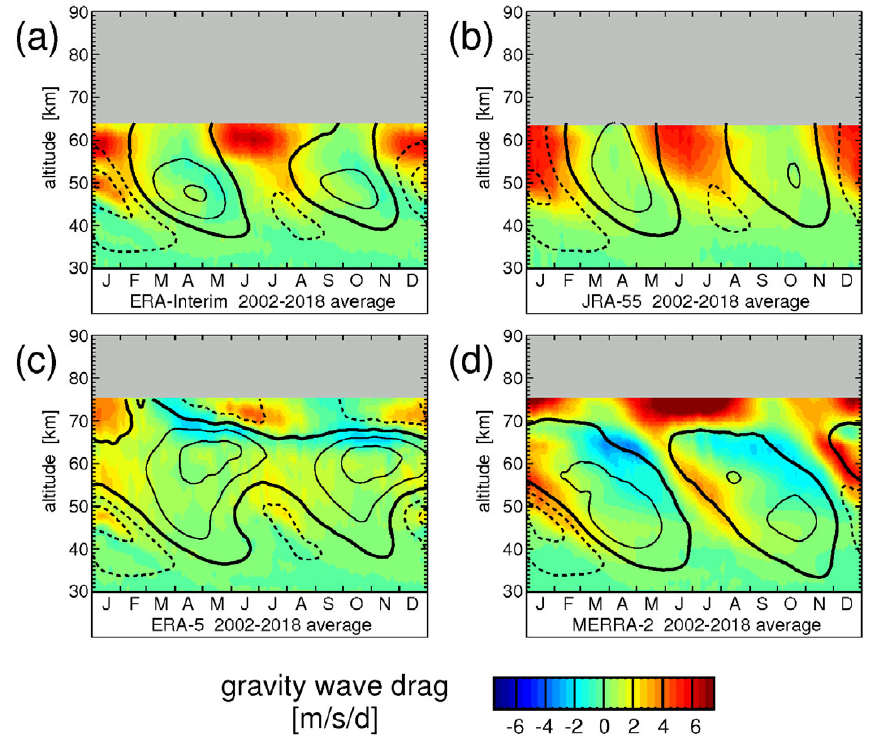
Figure 4. Typical seasonal variation of the total gravity wave drag X GW estimated from the TEM momentum budget. The values are averages over 10 ◦ S–10 ◦ N and the time period 2002–2018 for the four reanalyses (a) ERA-Interim, (b) JRA-55, (c) ERA-5, and (d) MERRA-2. Overlaid are contour lines of the respective wind data set. Contour line increment is 20ms − 1 . The zero wind line is highlighted in bold solid contour lines, and westward (eastward) winds are indicated by dashed (solid) contour